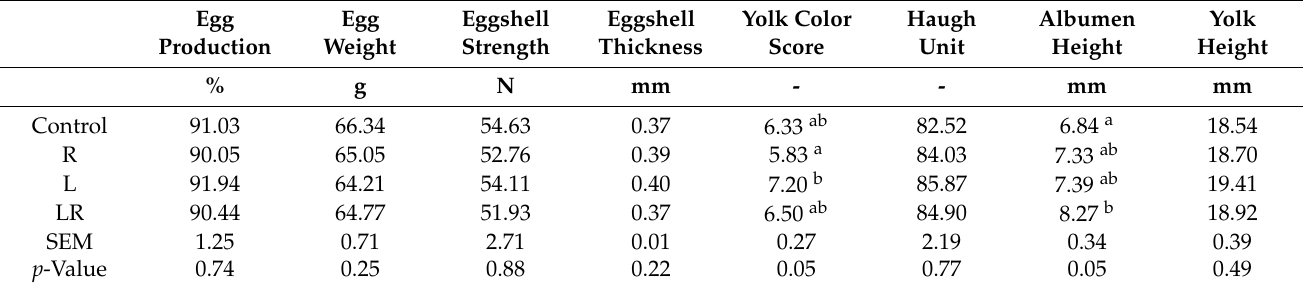
Table 3. Effect of Hydrastis canadensis on laying performance and egg quality in laying hens.